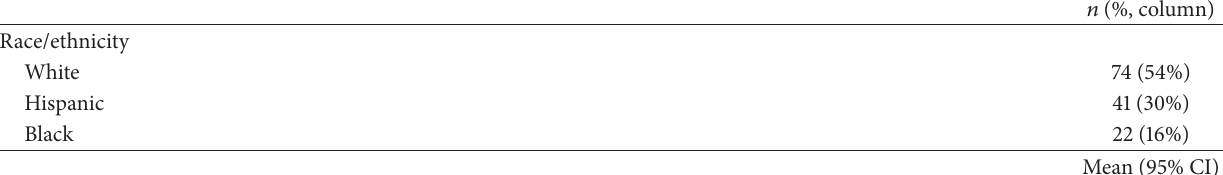
Table 1: General characteristics of the study subjects ( 𝑛 = 137